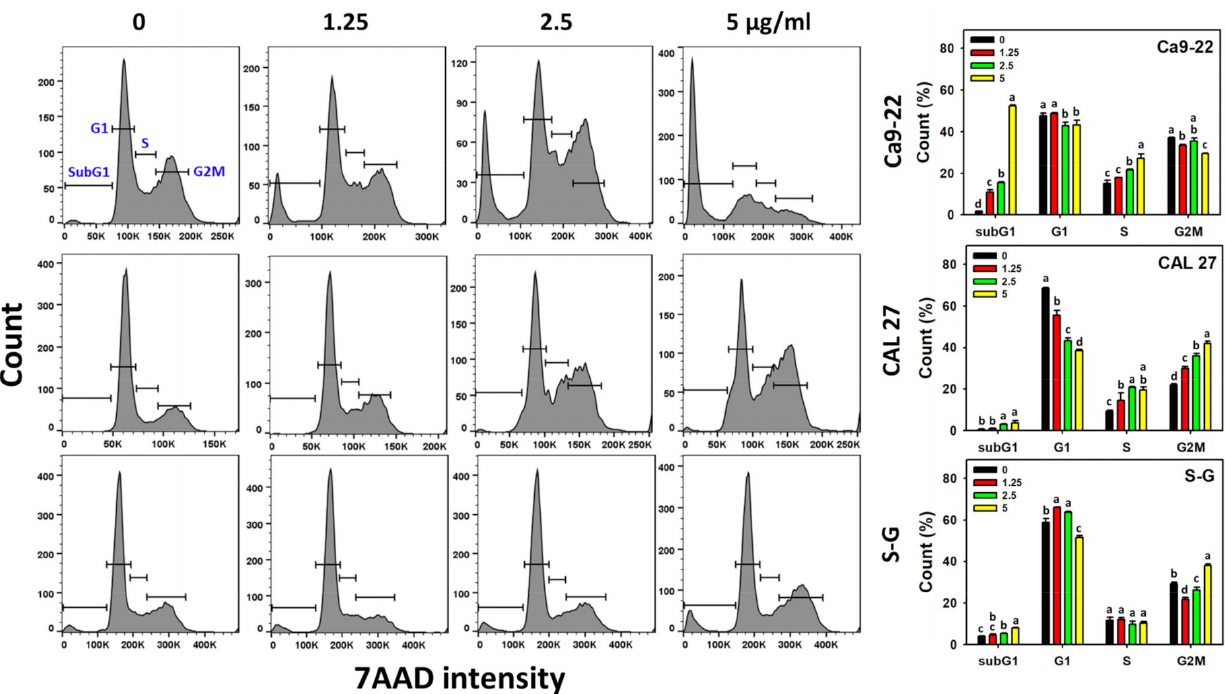
Figure 2. Cell cycle effects of SK1. Non-malignant (S–G) and oral cancer (Ca9-22 and CAL 27) cells were treated with SK1 (0 (0.1% DMSO in medium), 1.25, 2.5, and 5 µ g/mL) for 24 h. 0, 1.25, 2.5, and 5 SK1 indicate SK1 at 0 (0.1% DMSO in medium), 1.25, 2.5, and 5 µ g/mL, respectively. Data, means ± SD ( n = 3). Statistical software provided non-overlapping low-case letters indicate significant results for multi-comparison ( p <